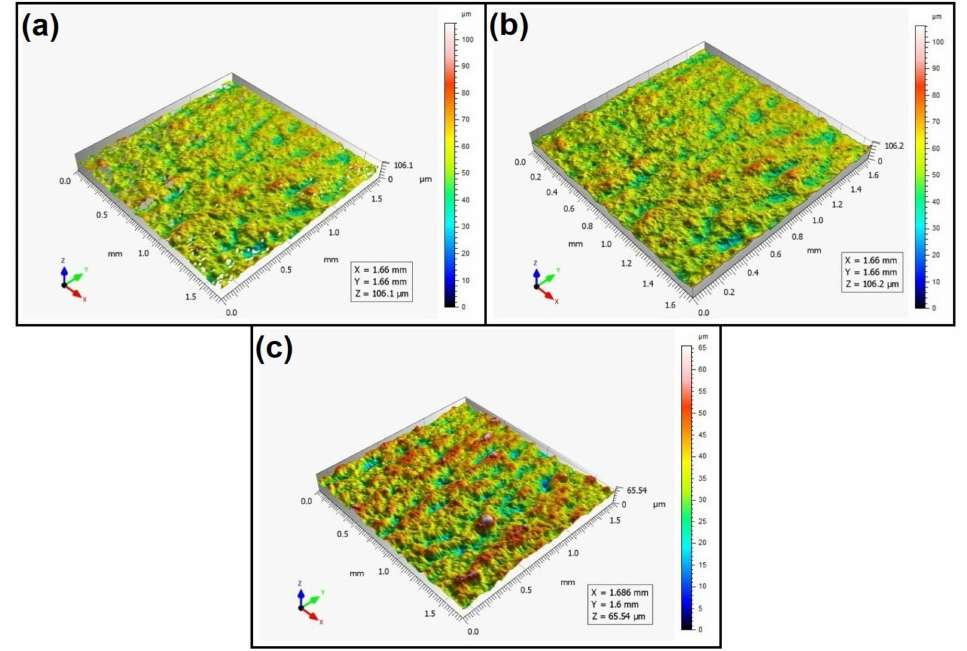
Figure 14. Surface topography of the element 3D printed using SLM technology (Pd = 90 ◦ ). ( a ) Taly- surf CCI—without filling non-measured points, ( b ) Talysurf CCI—after filling non-measured points, ( c ) Talysurf PGI